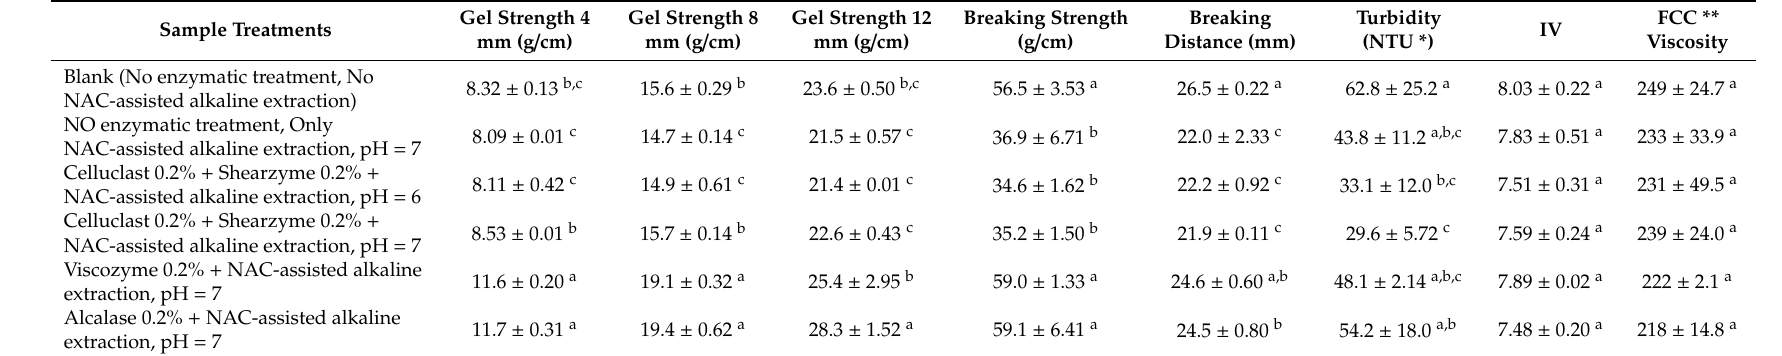
Table 4. E ff ect of protein extraction of seaweed Eurcheuma denticulatum on the quality of carrageenan gel. Quality is given as averages ± standard deviations. Di ff erent superscript letters in the same column indicate significant di ff erence at the confidence level of 95% ( α = 0.05; n =